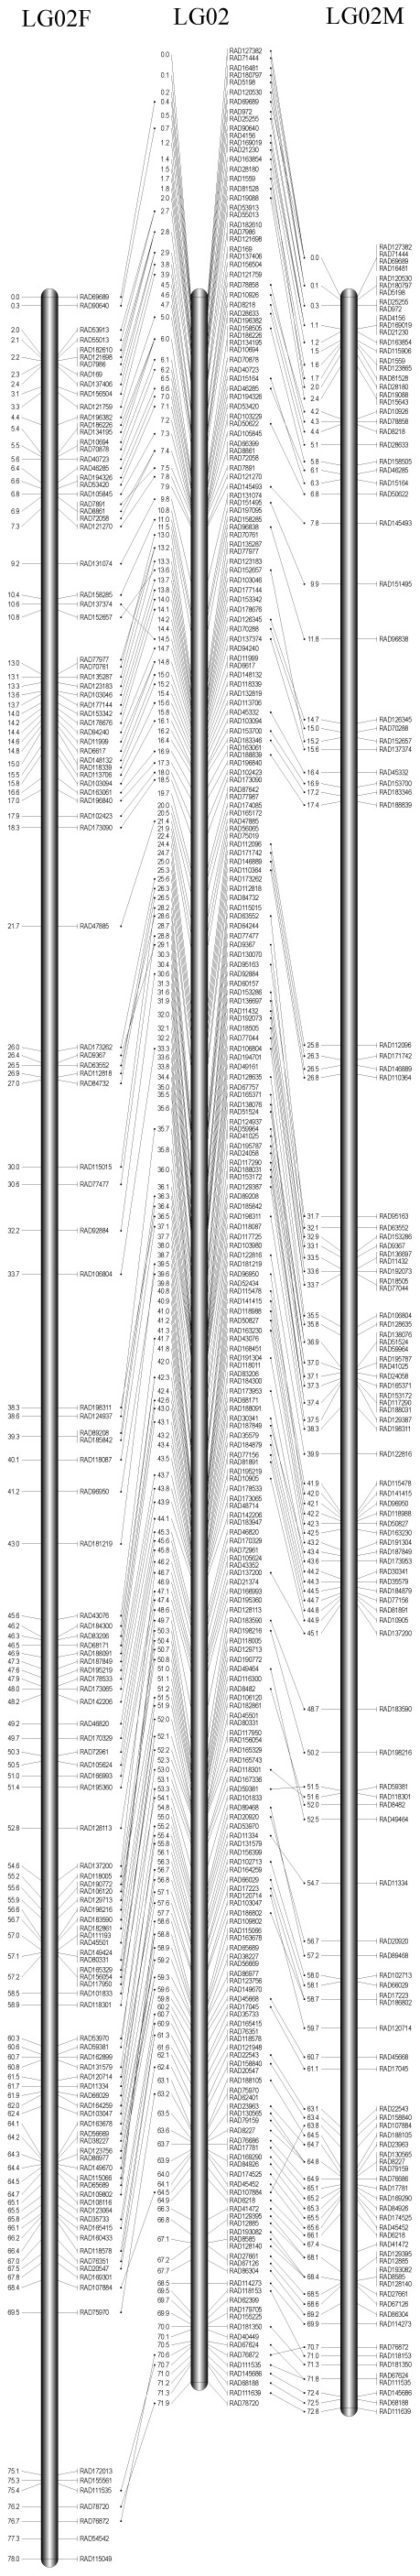
The linkage maps of LG02 for Z. jujuba (female, left), Z. acidojujuba (male, right) and their integrated map (middle) are shown as an example.Detailed lists of all the molecular markers, including their genetic distance in each linkage group, are presented in Table S4. All 12 LGs are presented in Figure S1, S2, and S3.